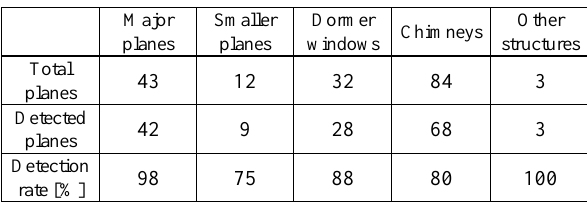
Table 2: Detection rate for segmented roof structures